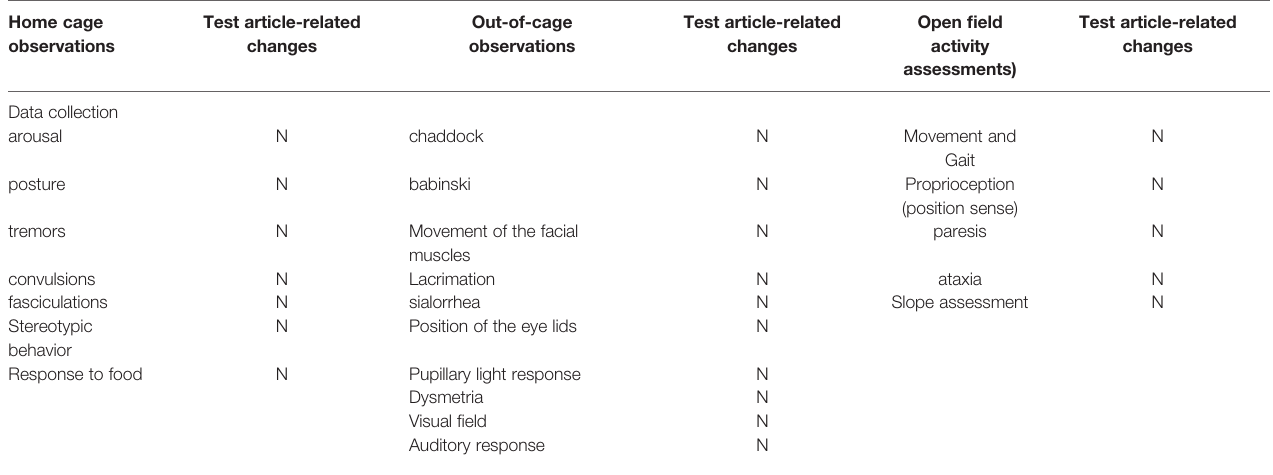
TABLE 4 | Functional observational battery for neurobehavioral assessments.